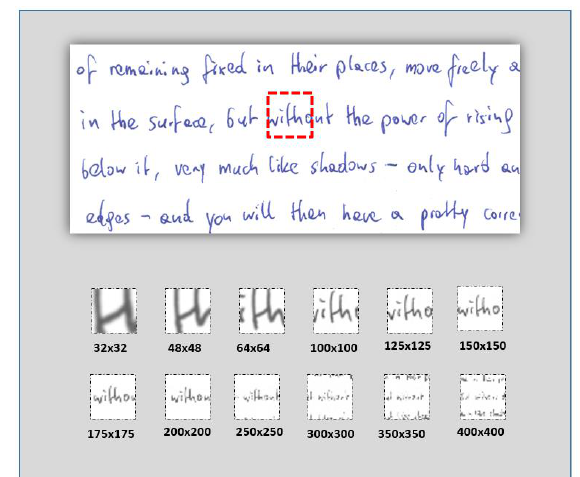
Figure 3. Samples of original patches of various sizes taken from the CVL dataset. These patches are subsequently resized to size 32x32